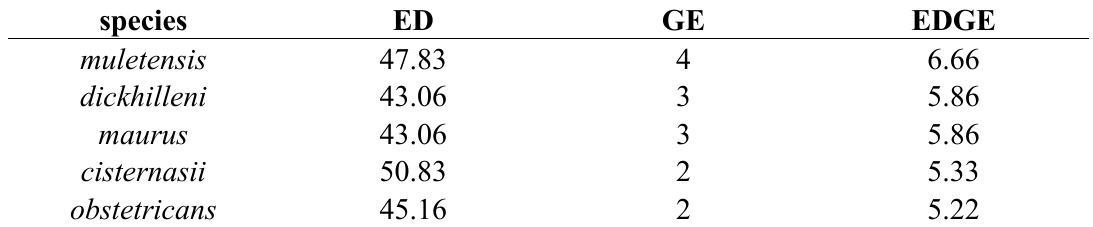
Table 2. Evolutionary distinctness (the phylogenetic measure provided by ED), conservation status (as GE, the ranked IUCN Red List categories) and composite EDGE values for the five extant species in